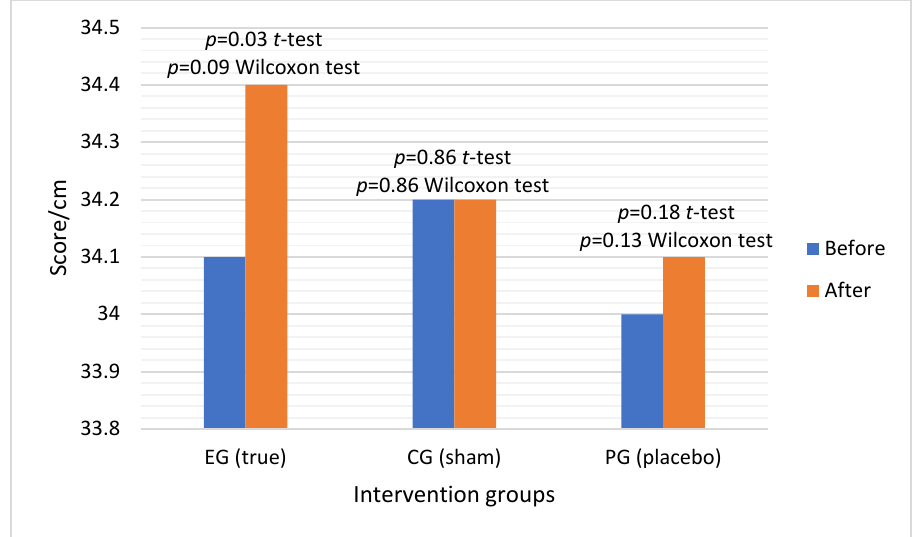
Figure 5. Average flexibility results before and after real, sham, and placebo interventions.